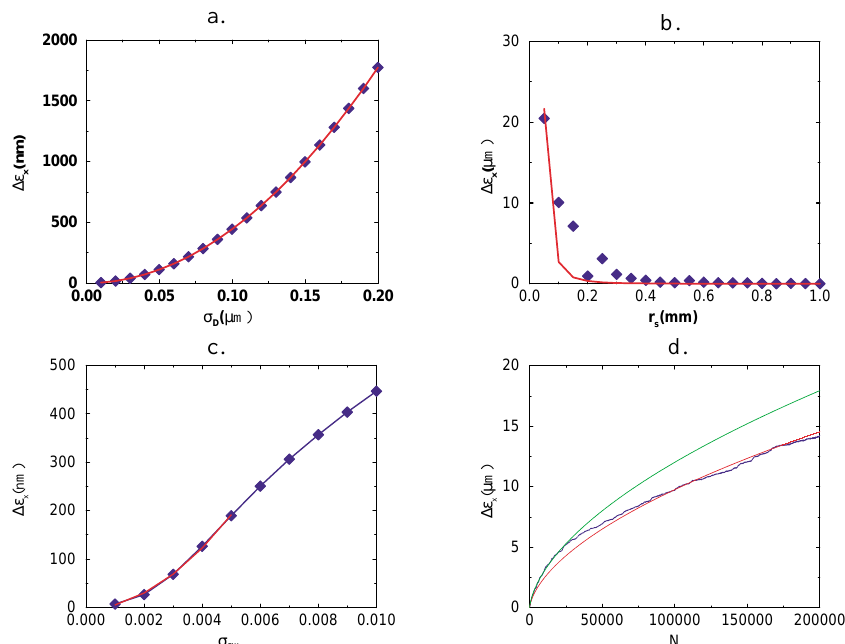
FIG. 5. (Color) Emittance degradation scalings: (a) dependence of the normalized emittance growth De x on the magnitude of the transverse stage offsets s D . Blue diamonds represent the code results and the red line is a quadratic fit. (b) Scaling of the emittance growth with the laser spot radius (which determines the wakefield curvature and, correspondingly, the betatron frequency). The [as dictated by (45)] fit to the numerical data (blue diamonds). (c) Scaling of the emittance growth with the red line is a 1 (cid:2) r 3 s phase spread. The change is from quadratic to linear dependence and finally saturation. (d) Long range behavior of the emittance degradation. Two fits to the numerical results (in blue): first (red) based only on the derived N dependence and second (green) based on the complete theoretical